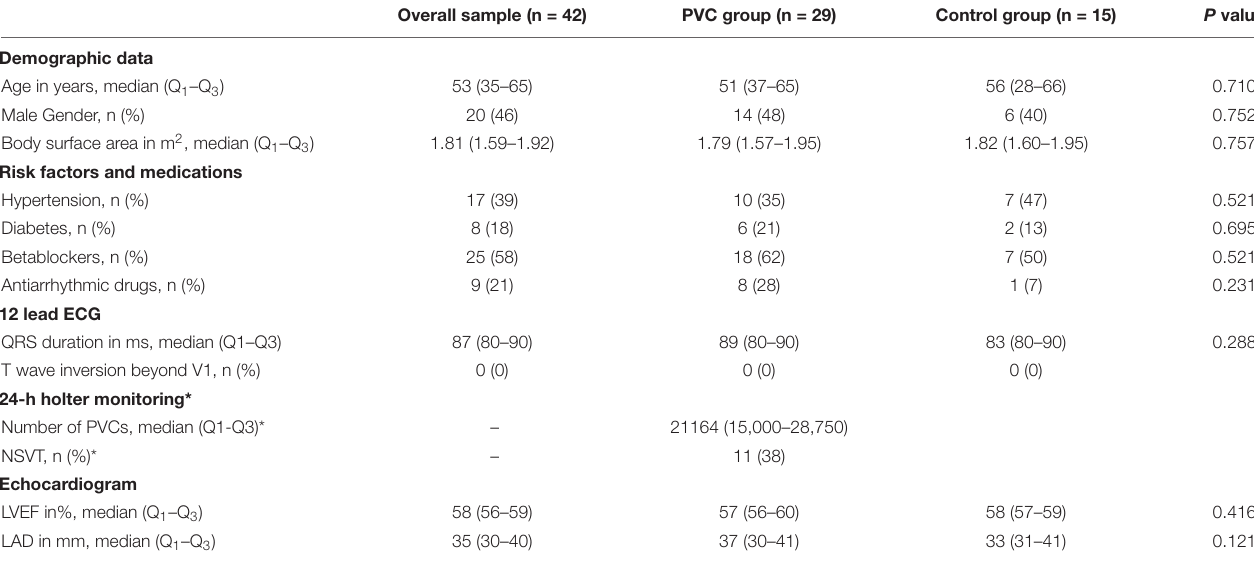
TABLE 1 | Baseline characteristics and comparison between PVC group and control group.